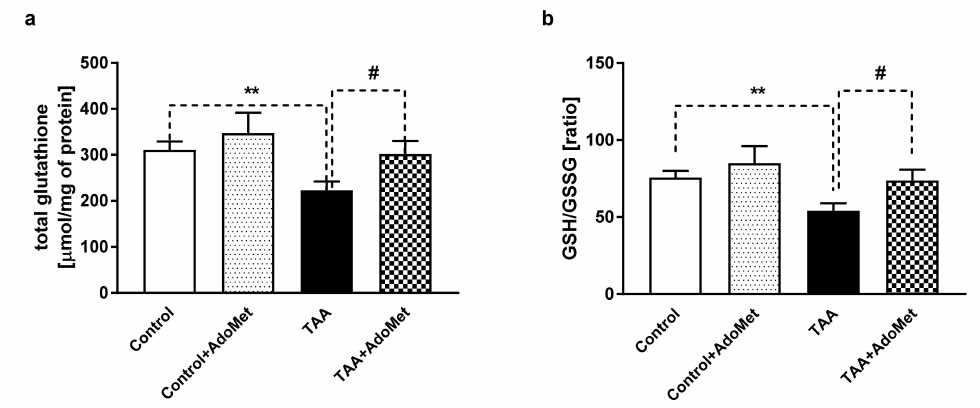
Figure 7. The e ff ect of AdoMet (10 mg / kg sc) treatment on the total glutathione level ( a ) and glutathione (GSH / GSSG) ratio ( b ) in the cerebral cortex of rats with acute liver failure (ALF). Results are presented as the mean ± SEM, n = 4–9. ** p < 0.01, # p < 0.05 compared with control or TAA group,